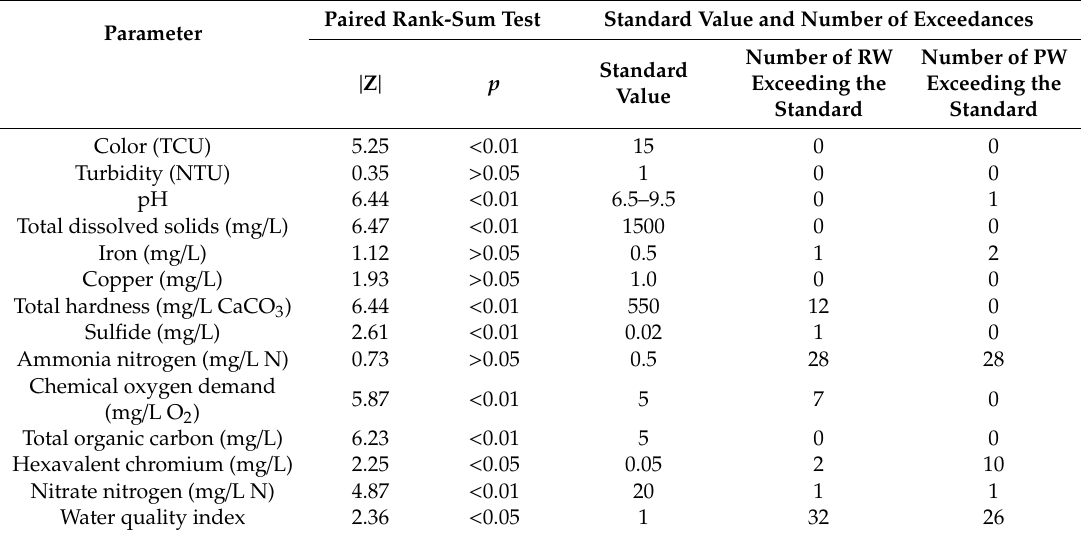
Table 2. Paired rank-sum test and the rates of water quality exceedance for parameters of the raw water RW and purified water (PW) samples ( n = 67). Paired Rank-Sum Test Standard Value and Number of Parameter